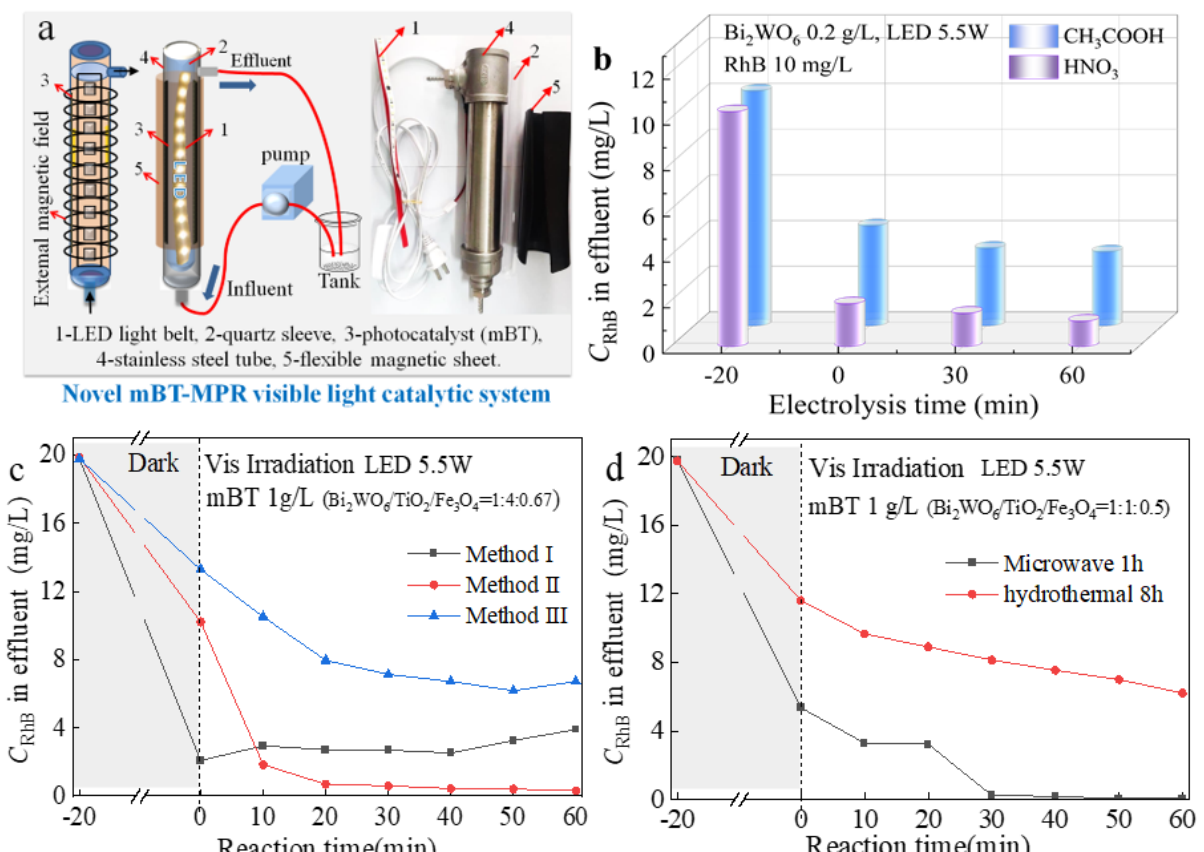
Figure 4. Schematic diagram of the mBT − MPR system ( a ), RhB degradation effect using Bi 2 WO 6 in different solvents ( b ), using mBT by three synthesis methods ( c ), and two heating modes ( d ).